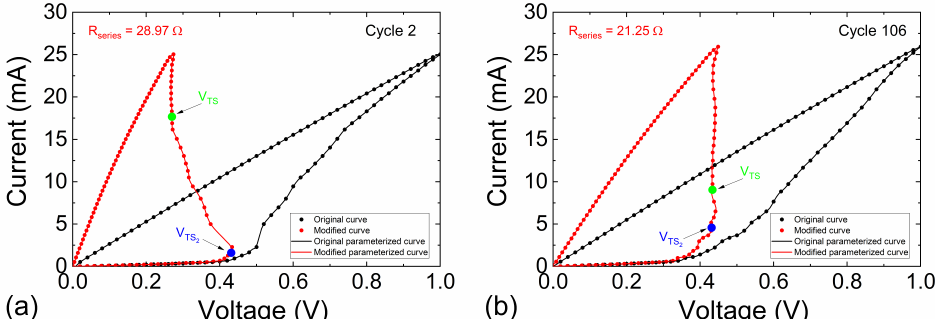
Figure 6. Current versus voltage curves for two different cycles ( a ) cycle 2 and ( b ) cycle 106. The orig- inal measured curves are shown in black symbols and the modified curves in red symbols. See in lines, with the corresponding colors, the parametrized curves in each case. The V TS shown. The cycle numbers correspond to the order of these cycles in the sequence that forms the resistive switching series measured, i.e., cycle 2 consists of the processes employed to change the device resistance for the second time in the